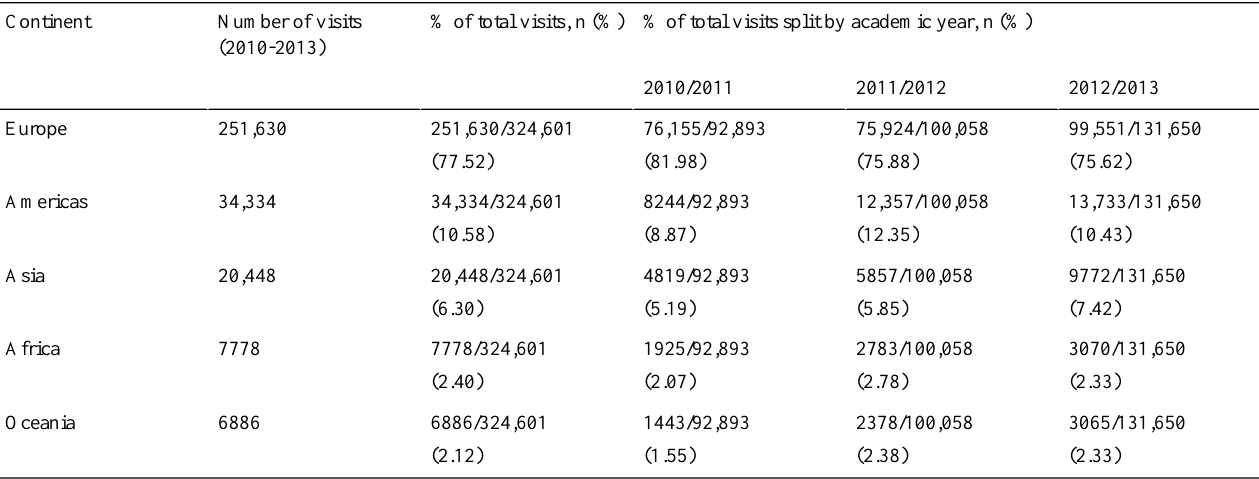
Table 3. Visits to the e-Bug website from continents across the globe between September 2010 and August 2013, and split by academic year.